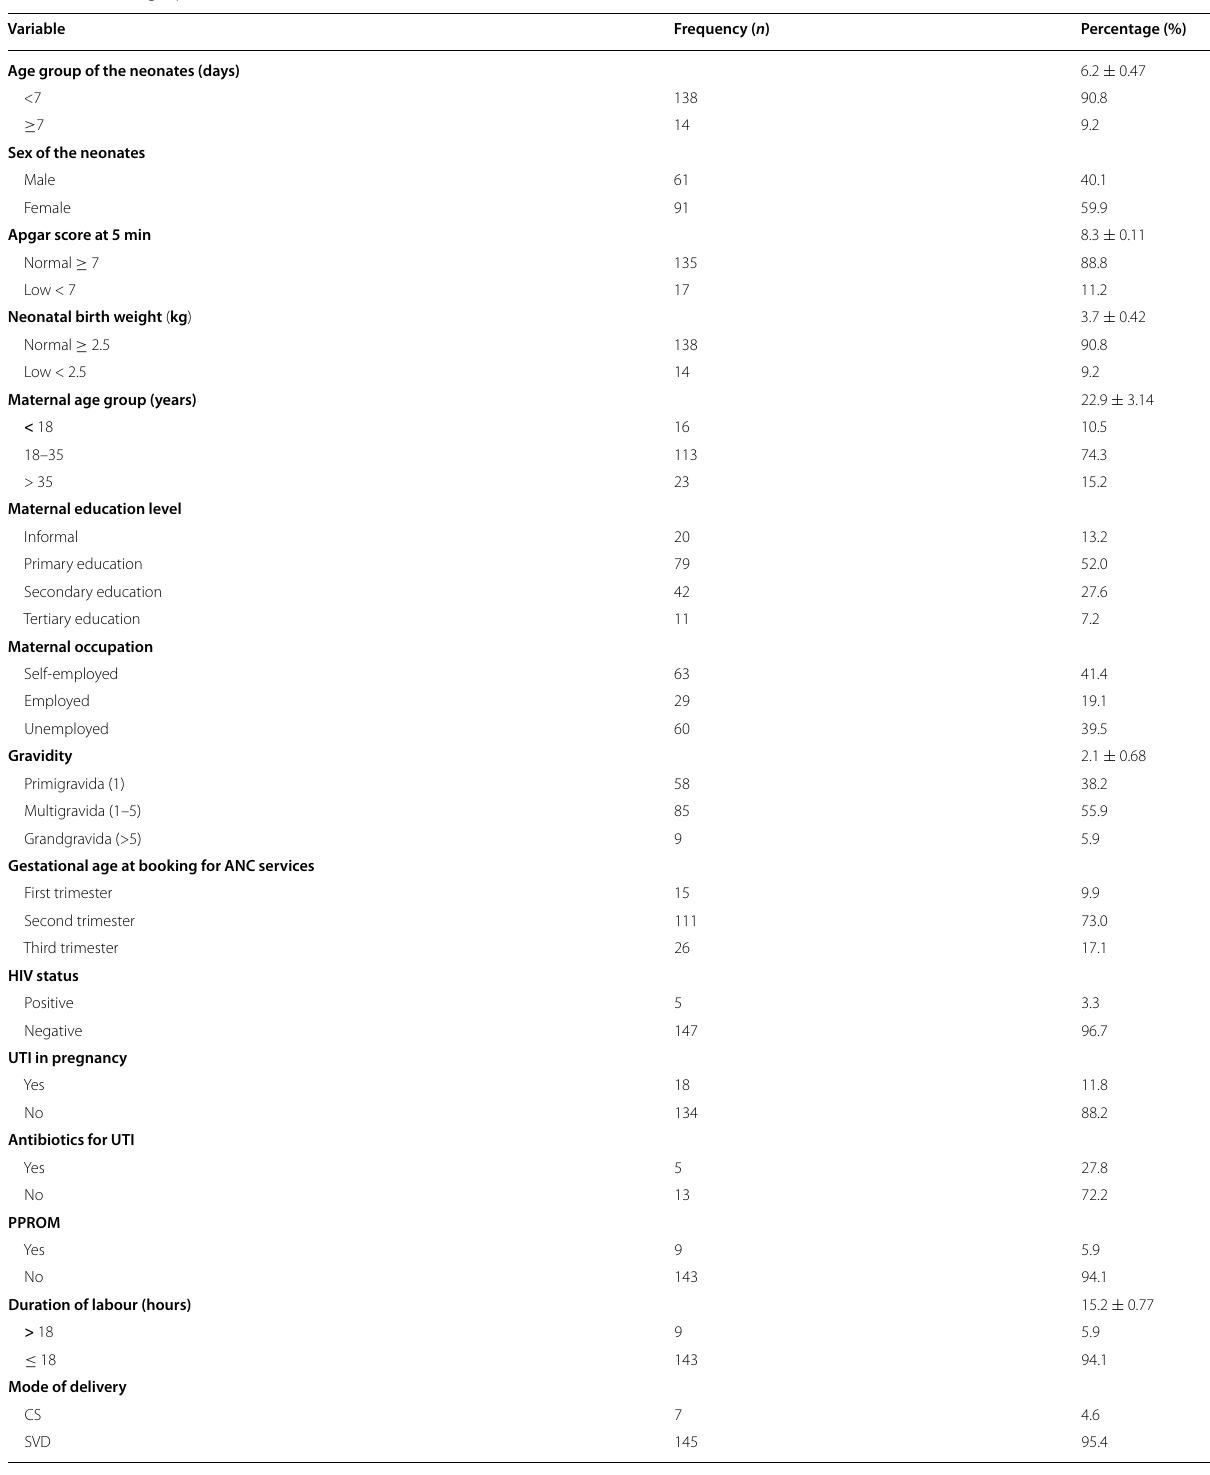
Table 1 Demographic and clinical characteristics of neonates and maternal ( N